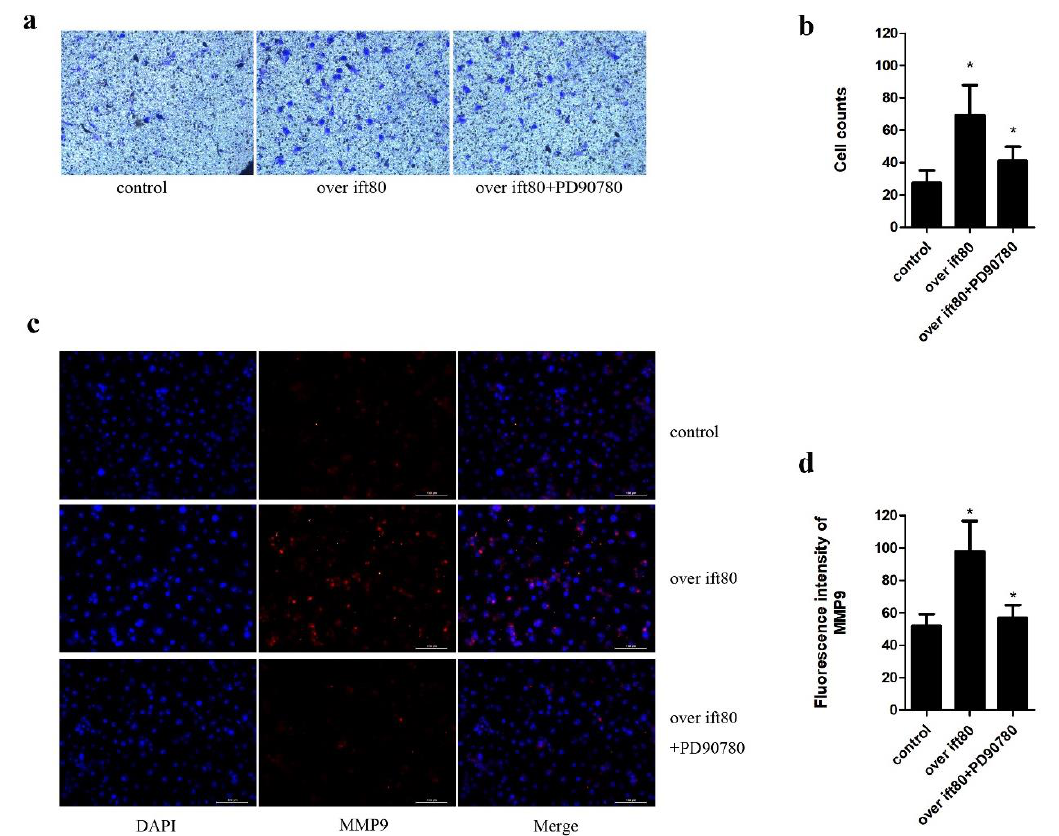
Figure 5. p75NGFR antagonist PD90780 significantly repressed the number of invasive SGC-7901 cells and the protein expression of MMP9. ( a ) Cell invasion was detected in SGC-7901 cells treated with or without PD90780, followed by transfection with the ift80 plasmid or empty vector (200×). ( b ) Quantification of images shown in a. Data points indicate the mean, while the error bars represent the SEM. Data were analyzed using the two- way ANOVA followed by Tukey’s multiple comparison